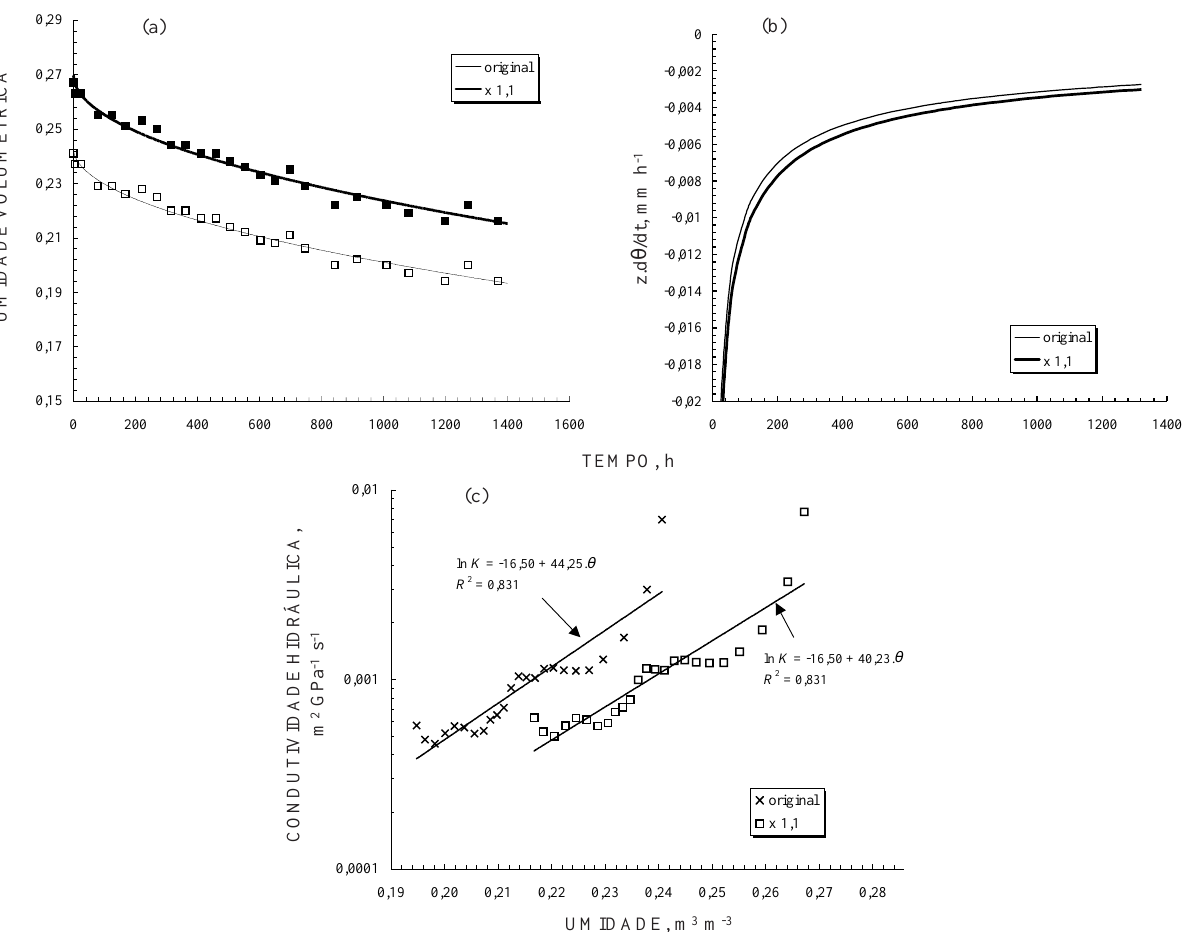
Figura 7. Seqüência exemplar mostrando como, para o local P ; 0,30-0,45 m, a superestimativa do coeficiente angular da equação 5b leva a (a) alterações nas umidades calculadas ao longo do tempo; (b) valores ligeiramente diferentes para z.d qqqqq /dt (variação da armazenagem) ao longo do tempo e (c) um coeficiente angular menor para a relação K- qq qq q